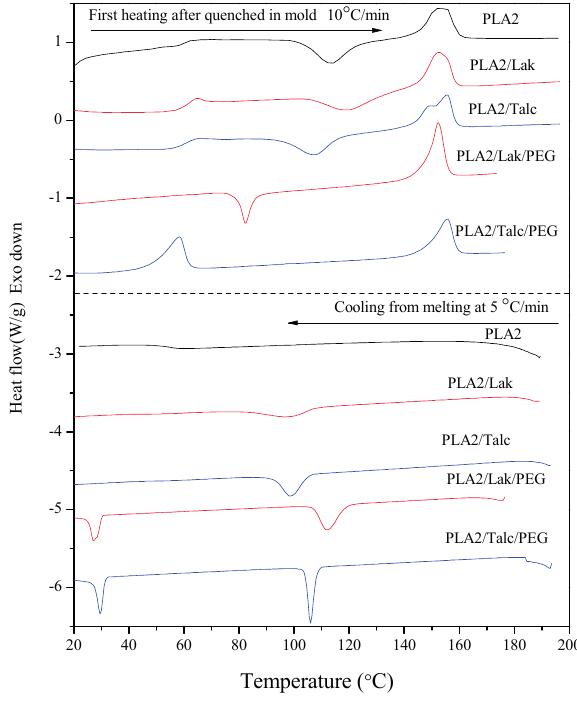
Figure 2. DSC traces of the heating-cooling cycle for PLA molded composites. (Exo means exothermal